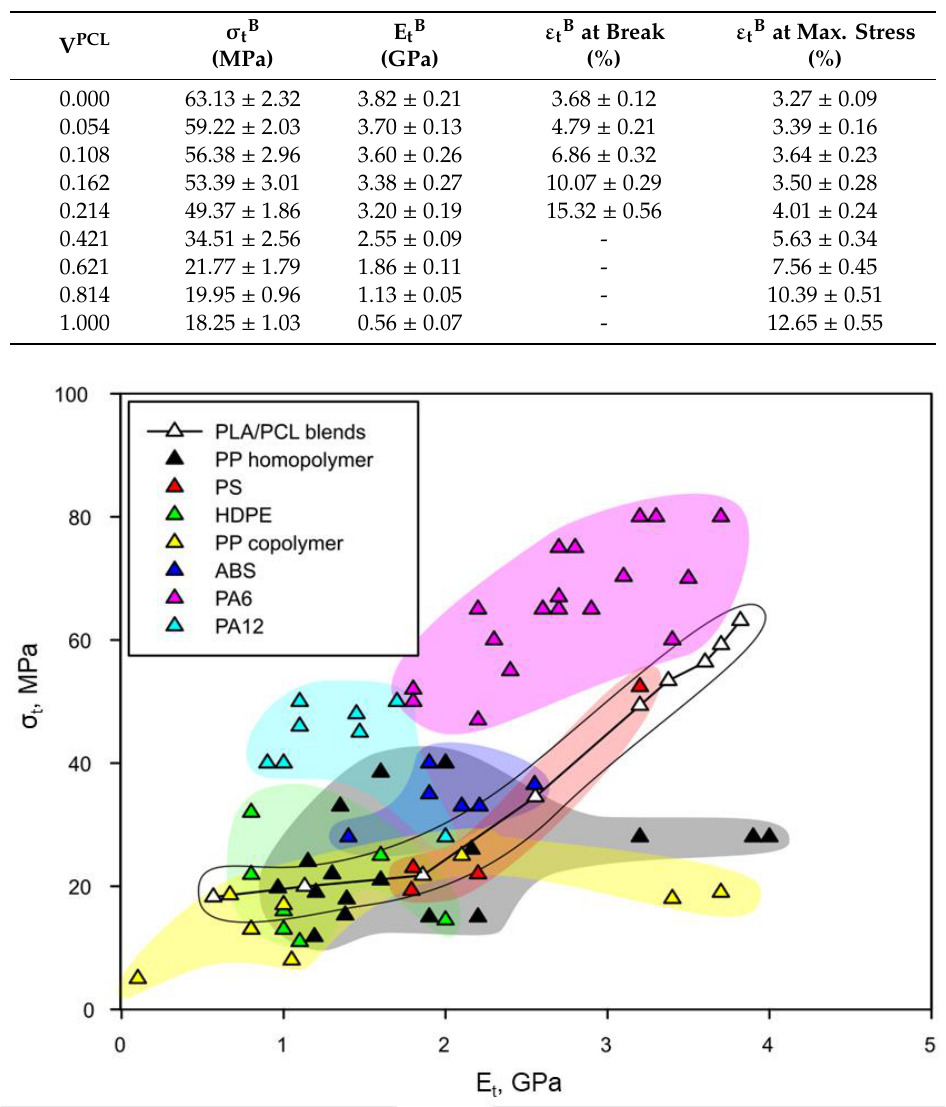
Figure 2. Ashby plot for tensile strength ( σ ) against Young’s modulus (E) for the obtained blends and compared to other commodity polymers.